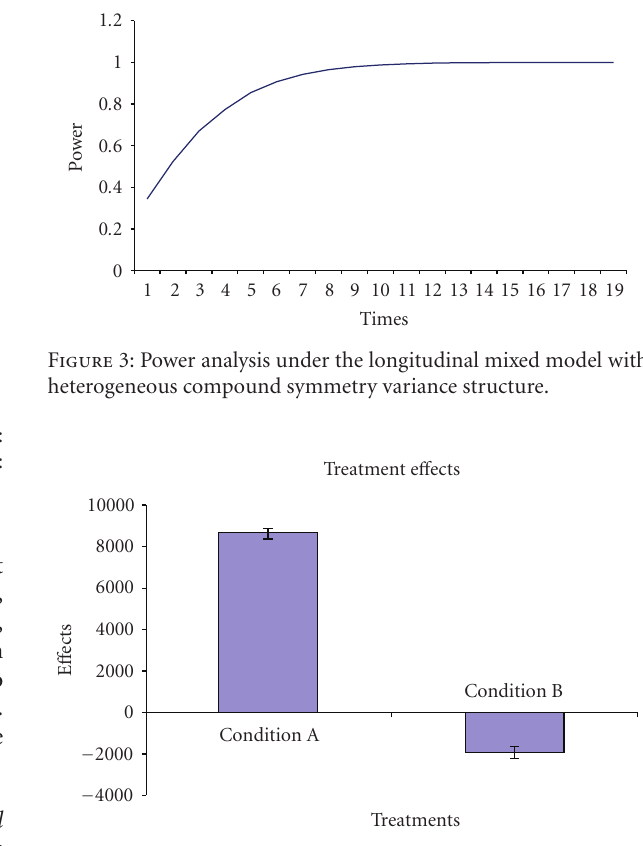
Figure 4: The estimation of condition e ff ects. Condition A: TSBDC+50 ug/mL FeCl 3 ,Condition B: TSBDC+400 ug/mL